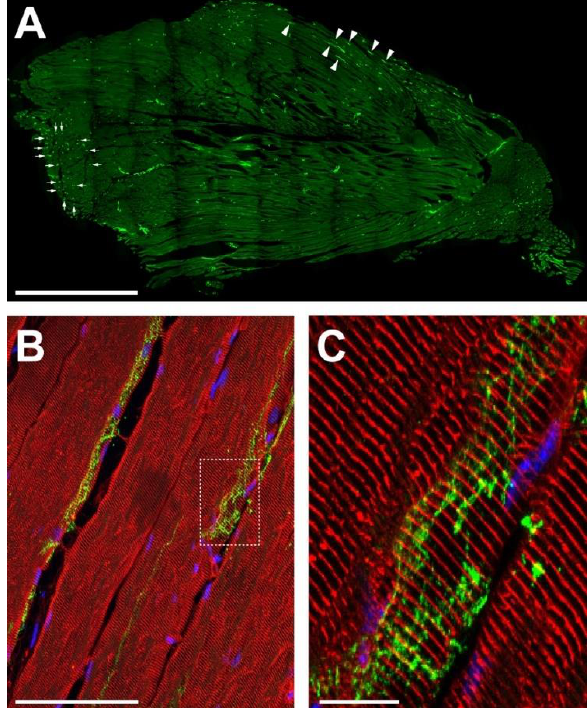
Figure 1. Sympathetic innervation is richly developed in mouse hindleg muscle. Tibialis anterior muscles of adult wildtype mice were cryosectioned longitudinally, then stained with antibodies against TH ( A – C , green) and, in addition, against α-actinin ( B and C , red). Nuclei were stained with 4′,6-diamidino-2-phenylindole (DAPI; B and C , blue). Pictures show single confocal sections, ( C ) depicts the detail in the boxed region of B . Arrowheads and arrows in ( A ) indicate alignment of sympathetic neurons with longitudinally and vertically cut muscle fibers, respectively. Scalebars show 500 µm, 50 µm, and 5 µm in ( A ), ( B ), and ( C ), respectively.